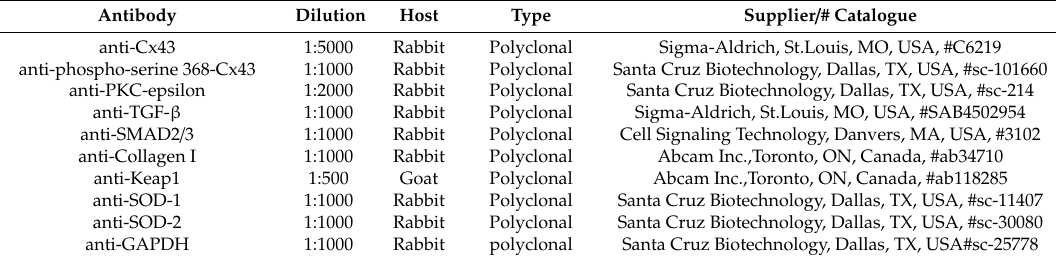
Table 1. Primary antibodies used for Western blot